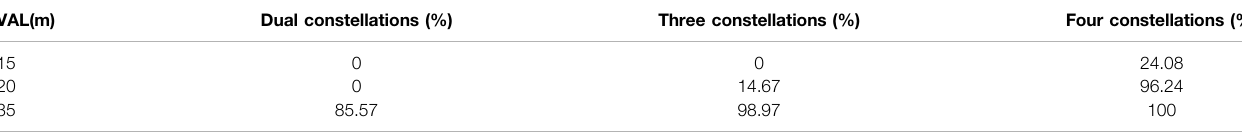
TABLE 5 | Availability analysis of the optimized multi-constellation integrity algorithm.